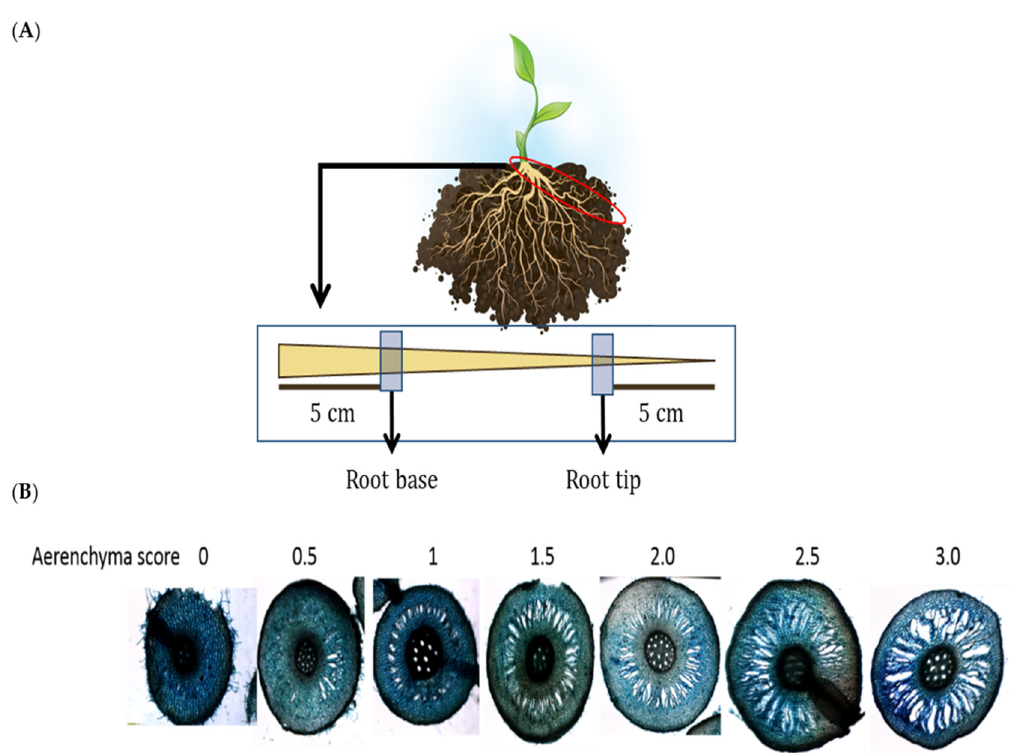
Figure 11. Determination of root aerenchyma formation. ( A ) The roots were removed from the plant and excised 5 cm from the root base, which is closer to the stem, and 5 cm at the root tip, which is away from the plant. ( B ) The aerenchyma score was assessed according to the descriptions from Mano and Omori [63] .